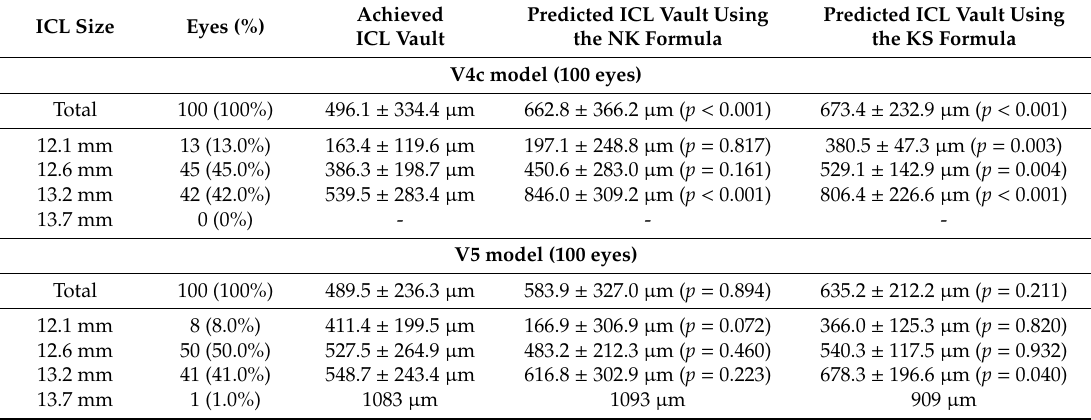
Table 3. The achieved vault using the manufacturer’s nomogram and the predicted vault by NK and KS formulas for each model (V4c and